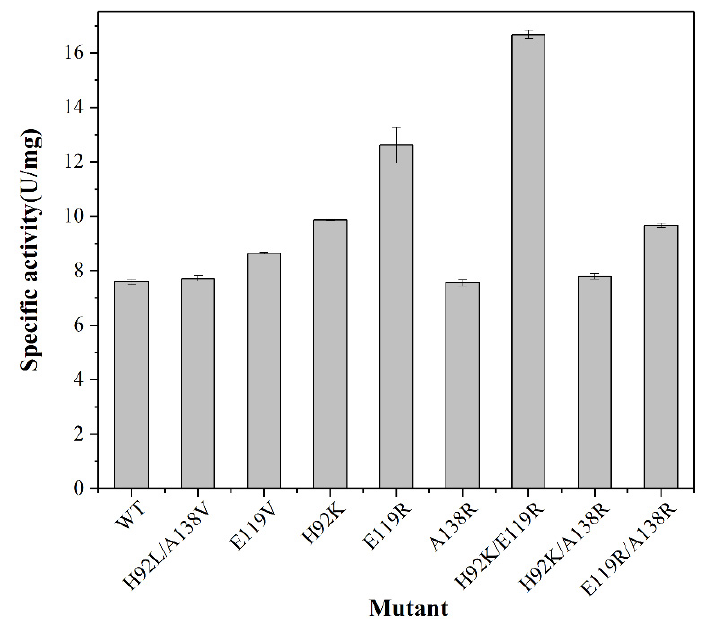
Figure 4. Initial enzyme activity test results of WT, H92L/A138V, E119V, H92K, E119R, A138R, H92K/E119R, H92K/A138R, and E119R/A138R at 30 °C (the value of each data point represents the average value).